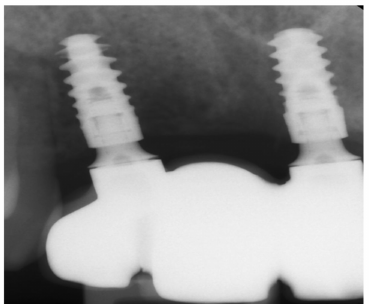
Figure 8. Single-tooth radiograph showing dental implants together with the final restauration.